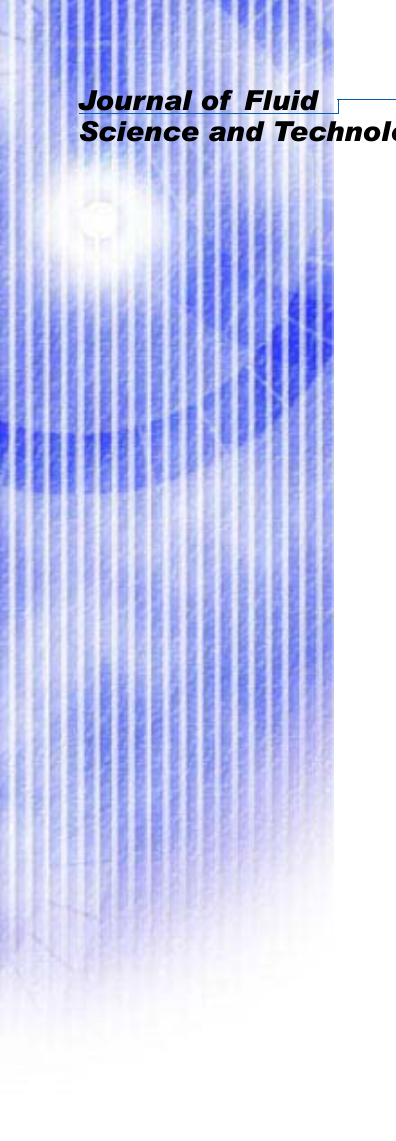
Fig.5 Variation of film thickness (Silicone Oil